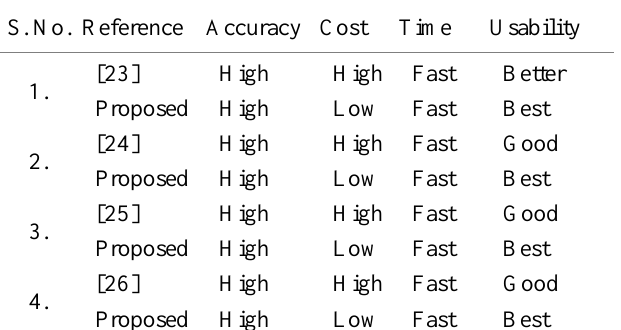
Comparative analysis of the proposed system with the existing